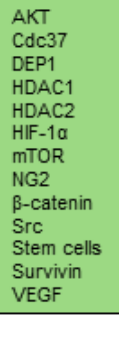
Figure 3. CK2-dependent modified proteins involved in angiogenesis and vascularization. Pro- teins that are activated in this process by CK2 modification are shown on the left (highlighted in green), and proteins that are restricted in their function are shown on the right (highlighted in red).